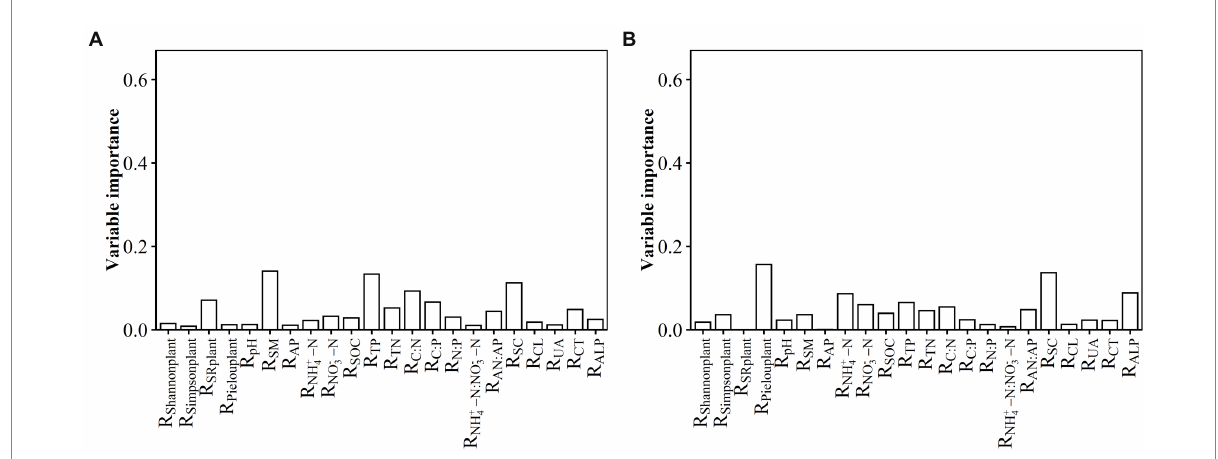
FIGURE 2 Relative contribution of observed soil and plant variables to the effect size of nitrogen input on (A) MPD in surface soil and (B) NRI in subsurface soil along the N input gradient in an alpine steppe. R shannonplant : effect size of nitrogen input on Shannon index of plant community; R simpsonplant : effect size of nitrogen input on Simpson index of plant community; R SRplant : effect size of nitrogen input on species richness of plant community; R pielouplant : effect size of nitrogen input on Pielou index of plant community; R SM : effect size of nitrogen input on soil moisture; R AP : effect size of